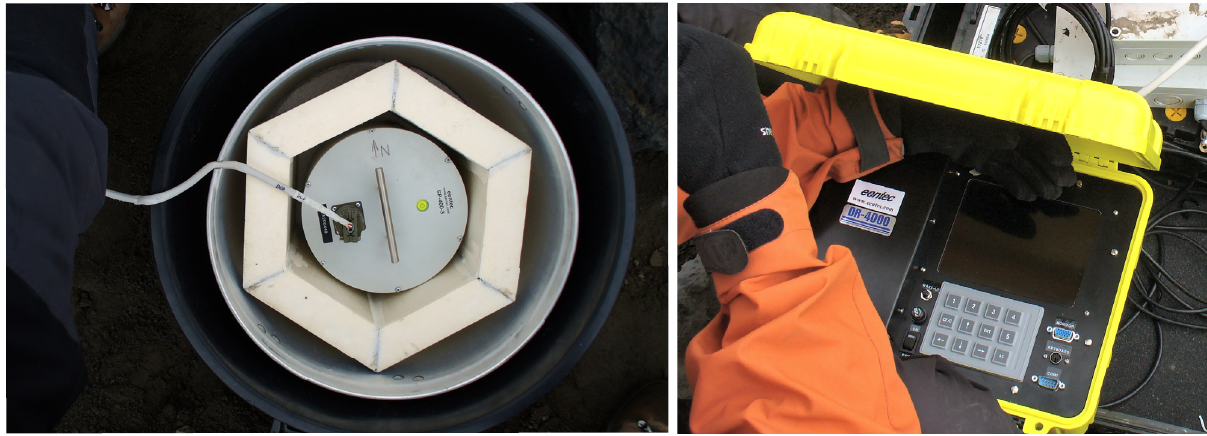
Figure 12. Seismometer (left) and data acquisition system (right) of the permanent station DCP, installed in February 2008 at Deception